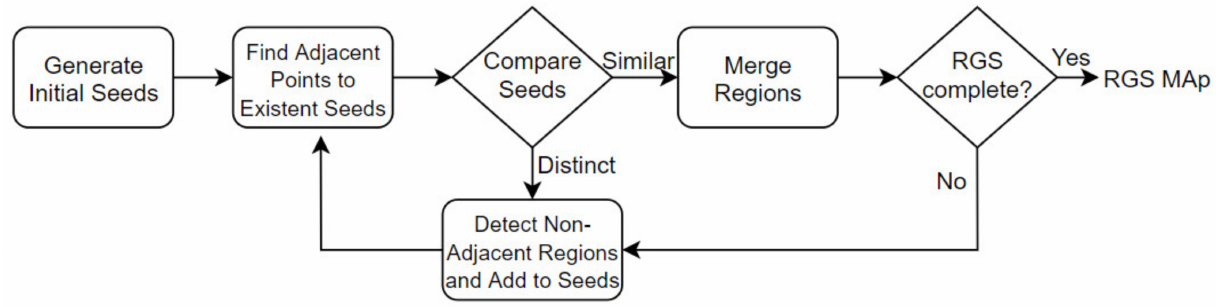
Figure 5. Flowchart of the Region Growing Segmentation. A key idea of this algorithm is to merge adjacent points and form the point clusters. As soil data are dense and very close to each other, they form the largest cluster (the cluster to be filtered) as a result of this